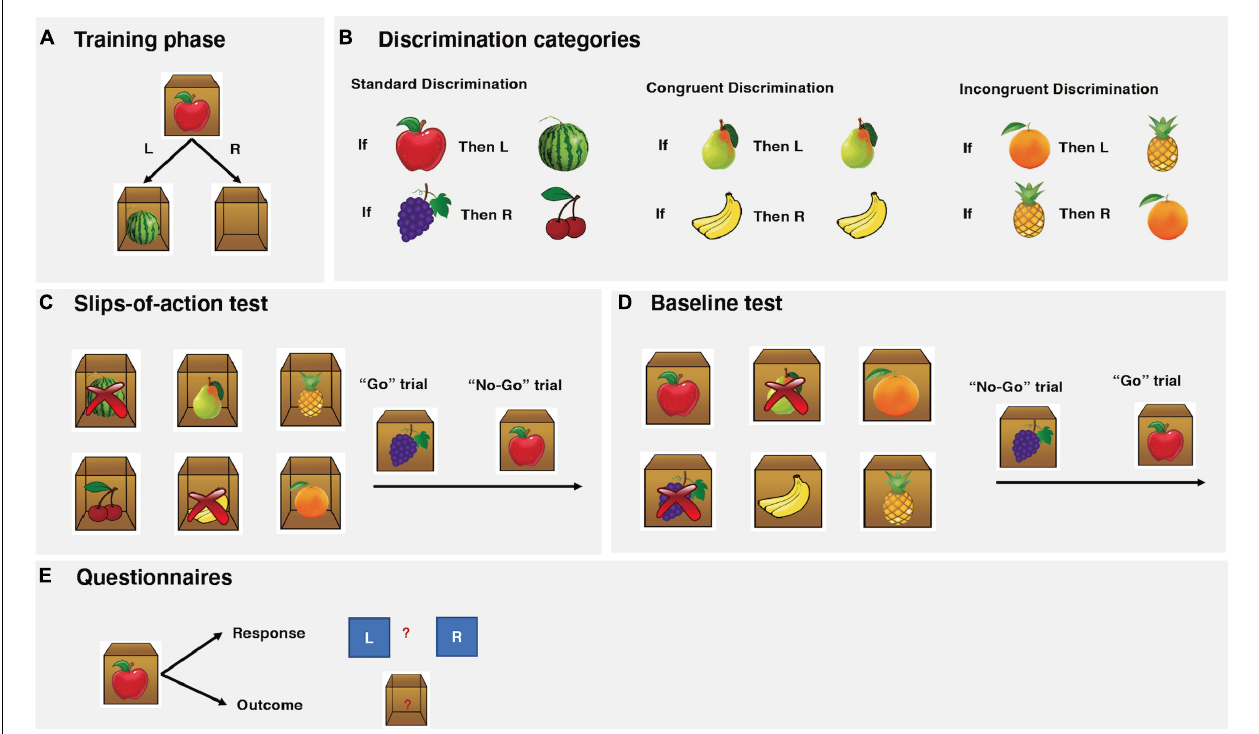
FIGURE 1 | Instrumental task paradigm descriptions. (A) The instrumental training phase. In this example from the standard association, participants are presented with an apple stimulus on the outside of the box. If the correct (left) key is pressed, participants are rewarded with a watermelon inside of the box and earned points. If the incorrect (right) key is pressed, an empty box is shown and no points are awarded. (B) The three association categories: standard, congruent, and incongruent. (C) The slips-of-action test. Six open boxes with outcomes inside are shown, two of which are marked with crosses, indicating these two outcomes are now devalued and will lead to subtraction of points. Subsequently, participants are presented with a series of fruit stimuli. The participants are asked to press the correct keys (“Go”) when the stimulus signals a still-valuable outcome but to refrain from responding (“No-Go”) when the responding outcome has been devalued. In this particular example, participants should press the correct key when the grapes stimulus is depicted (“Go”) but refrain from responding to the apple stimulus (“No-Go”). (D) The baseline test. The procedure is identical to the slips-of-action test, except that participants were shown six stimulus fruits (as opposed to outcome fruits). In this particular example, participants should press the correct key when the apple stimulus is depicted (“Go”) but refrain from responding to the grapes stimulus (“No-Go”). (E) Questionnaires: Participants were asked to make corresponding response and outcome for each stimulus with paper questionnaires.